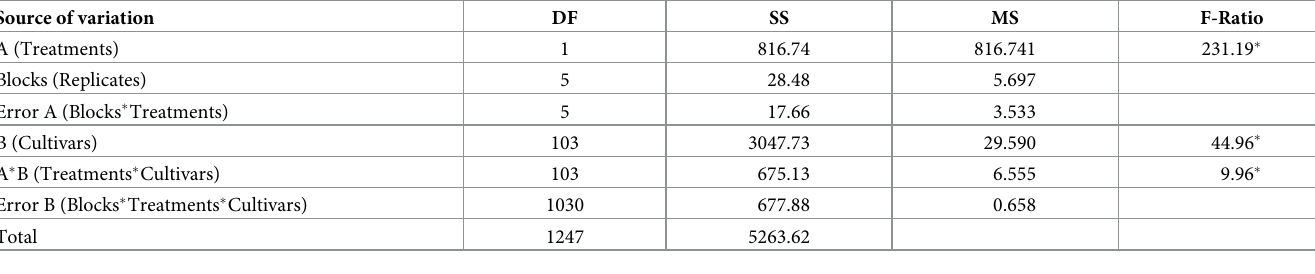
Table 6. Analysis of variance of cultivars and disease treatments for purity percentage. Source of